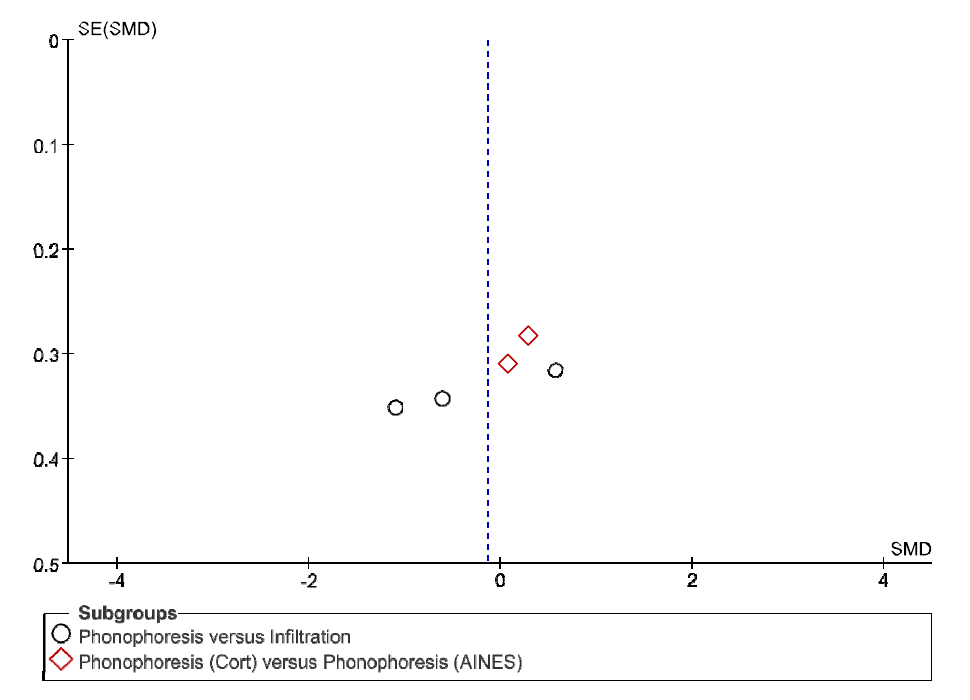
Figure 23. Phonophoresis for CNVS.